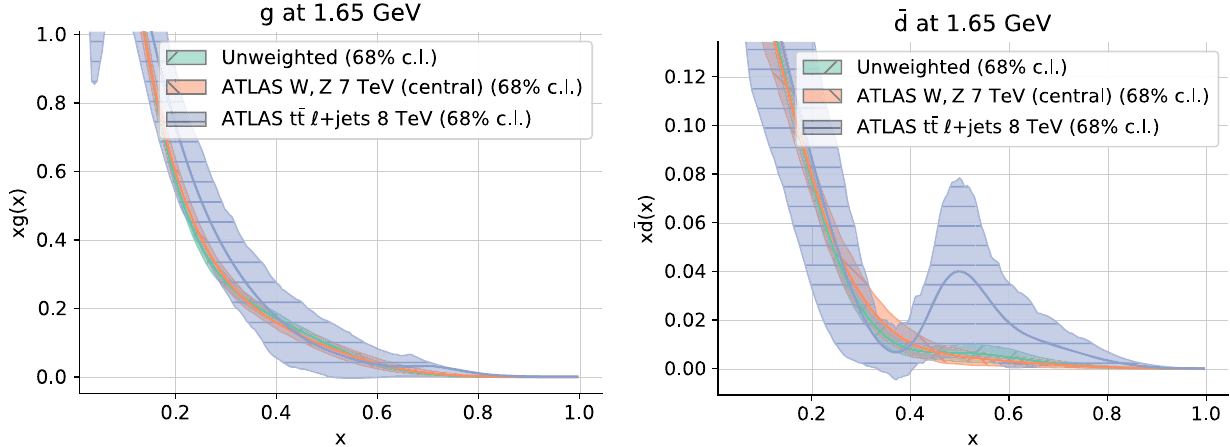
Fig. 14 The gluon (left) and antidown (right) PDFs at Q = 1 . 65 GeV at large x , for the unweighted fit and the weighted fits in which the ATLAS W , Z 7 TeV ( L = 4 . 6fb − 1 ) (central) and the ATLAS t ¯ t (cid:5) +jets 8 TeV datasets are assigned large